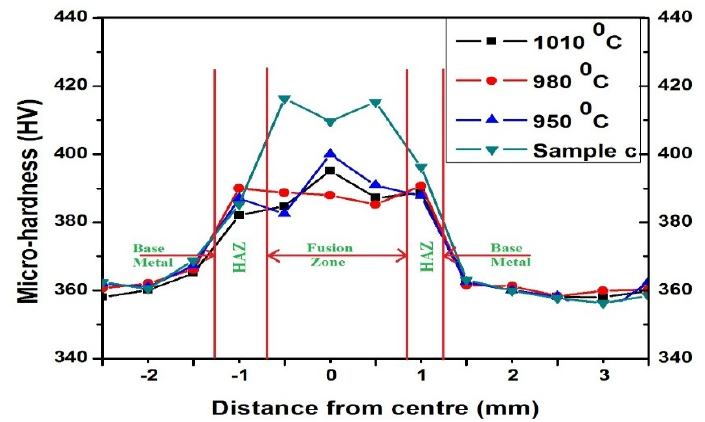
Figure 12. Variation of hardness in di ff erent conditions.